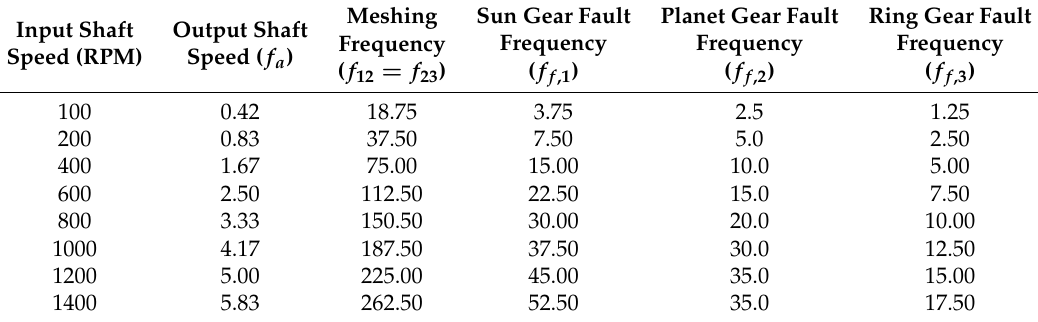
Table 2. Characteristic frequencies of the PGB at varied input shaft speeds (Hz).